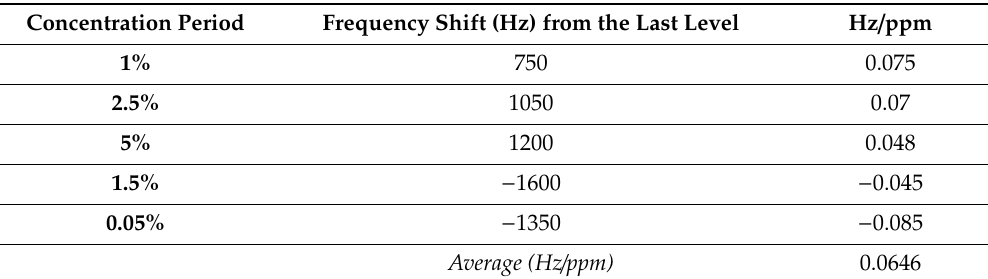
Table 5. Frequency shift of the micro-resonator at di ff erent CO 2 concentrations.